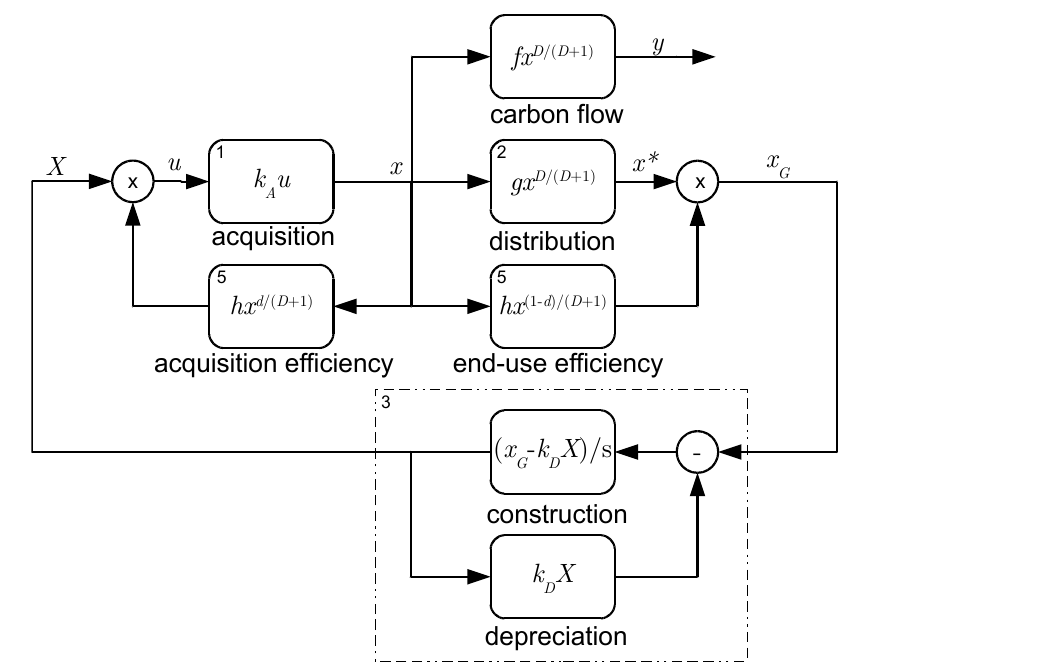
Figure 5. The system diagram representation of the endogenous growth model set out in Eqs. (1)–(5). Numbers in boxes denote which equations apply. s in the “construction” transfer function is the derivative operator, d/d t